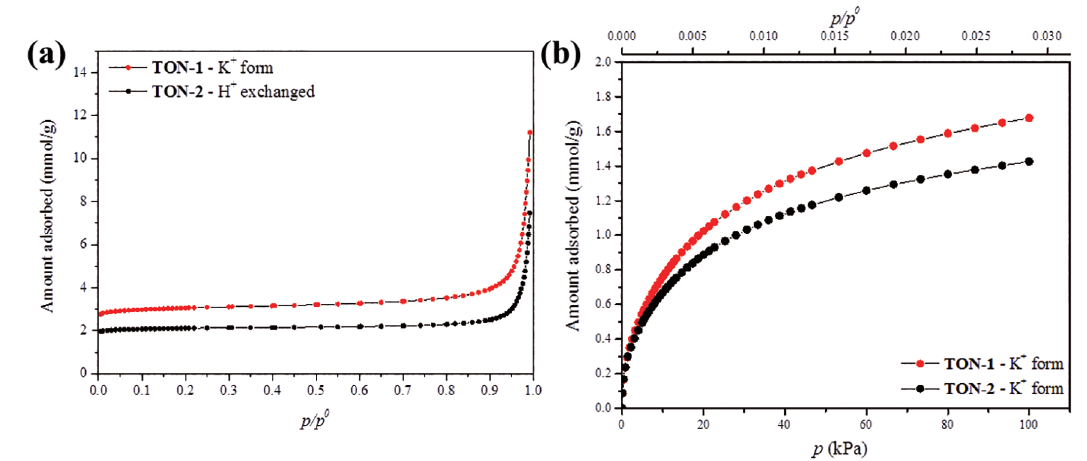
at -196 ºC (a) and CO at 0 ºC (b). 2 2